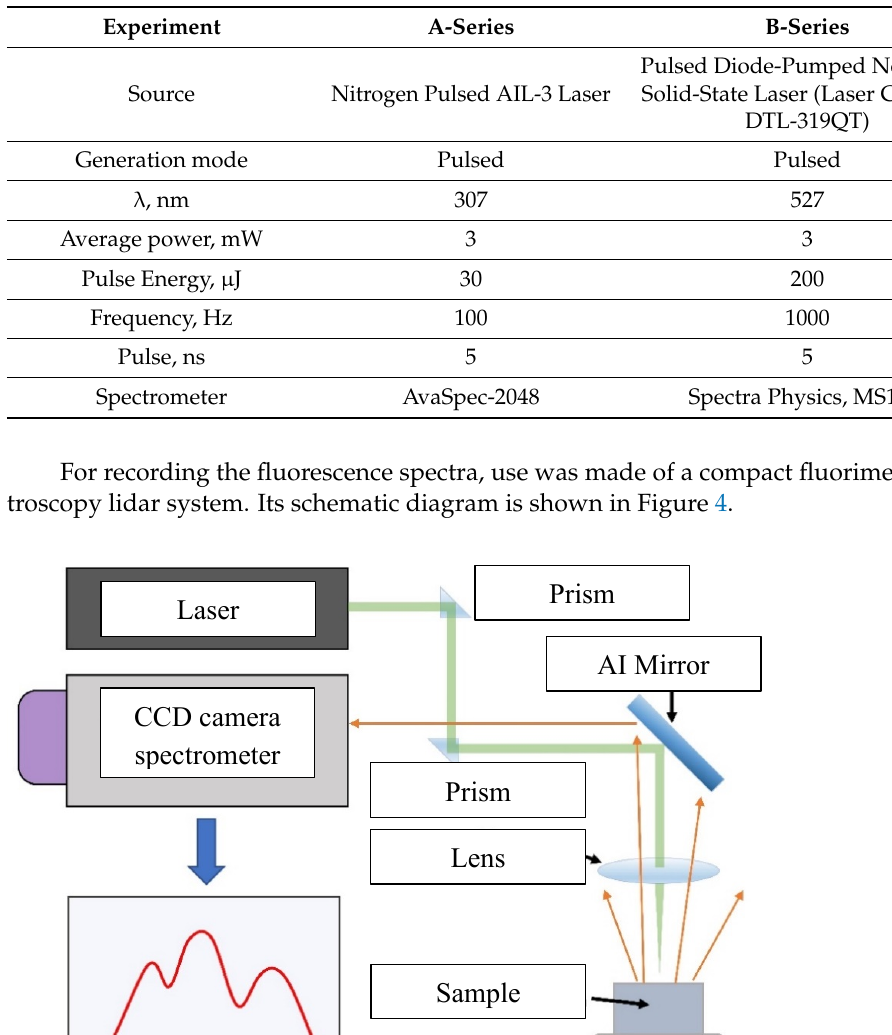
Table 1. Schemes of experiments, laser sources, and spectrometers.